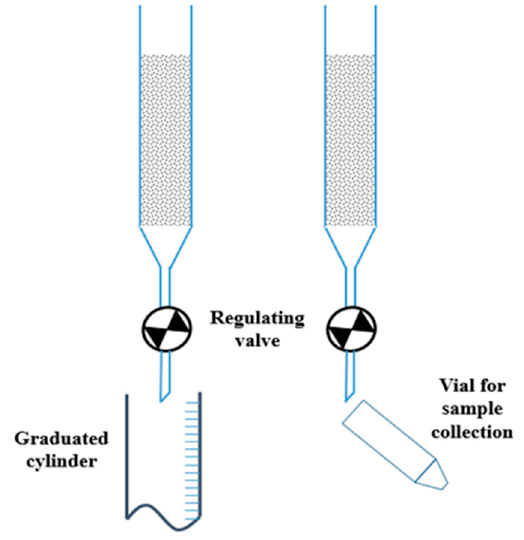
Figure 1. Column experiment and sample collection.